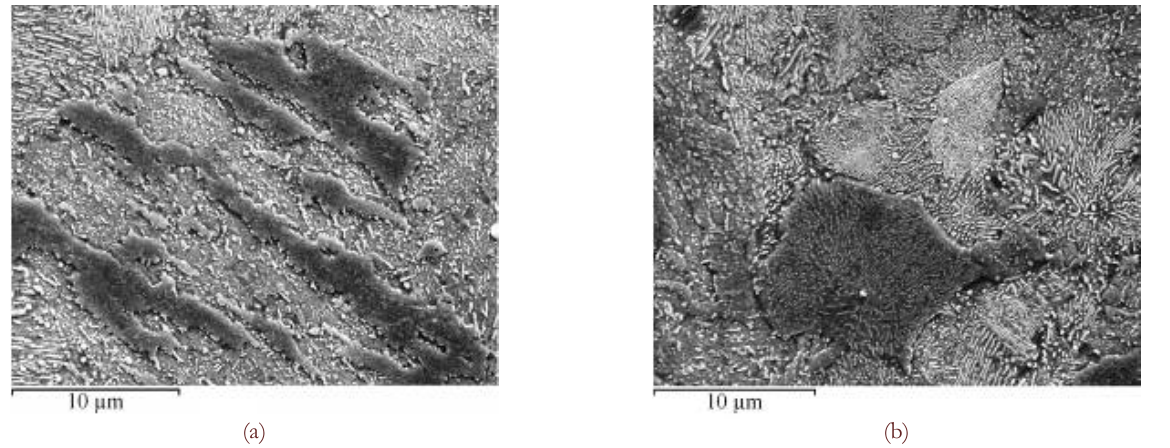
Figura 3: Microscopia elettronica a scansione dei costituenti metallografici di Fig. 2d: bainite superiore modificata dal rinvenimento (a) e perlite fine (b). Attacco Nital. Figure 3: Scanning Electron Microscopy of metallographic constituents shown in Fig. 2d; upper bainite modified by tempering (a) and fine pearlite (b). Nital etch.